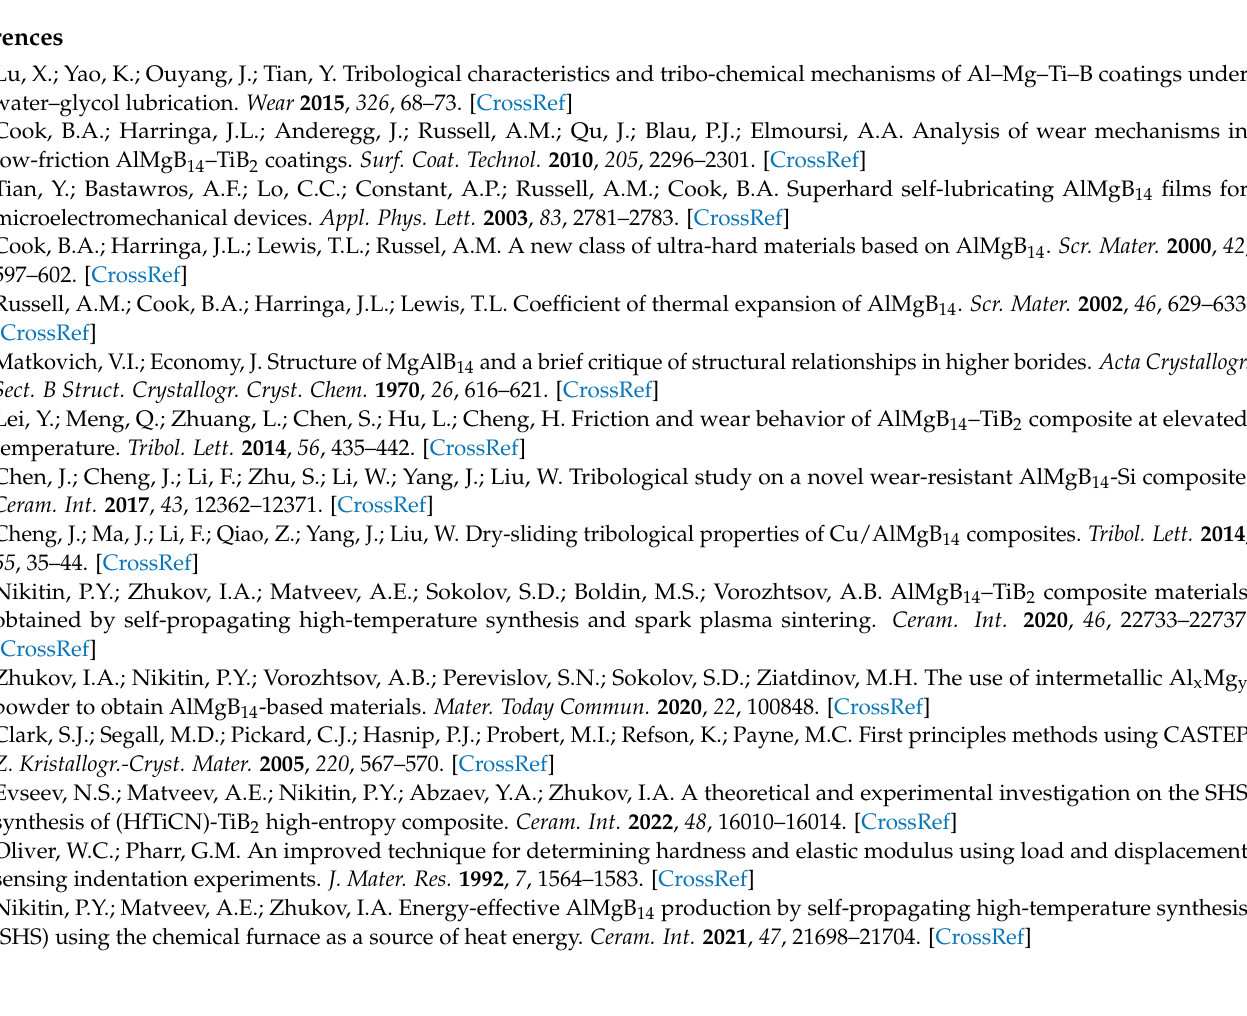
Figure S2: EDX_results to Figure 1. Figure S3: Nanohardness